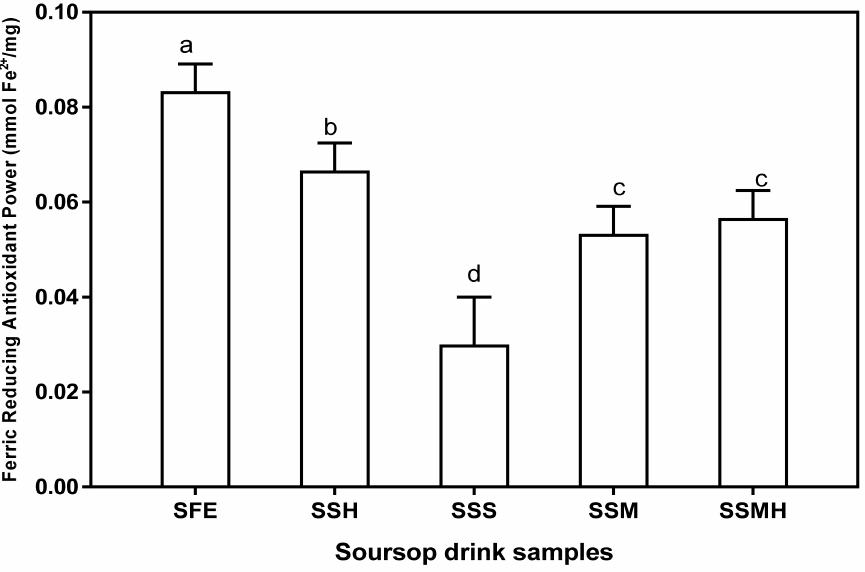
Figure 2. Ferric reducing antioxidant power of formulated soursop drink. Values are means ± SDs; bars with different letters (a–d) are significantly different ( p < 0.05); SFE: soursop fresh extract; SSH: soursop + honey; SSS: soursop + sugar solution; SSM: soursop + milk; SSMH: soursop +milk +